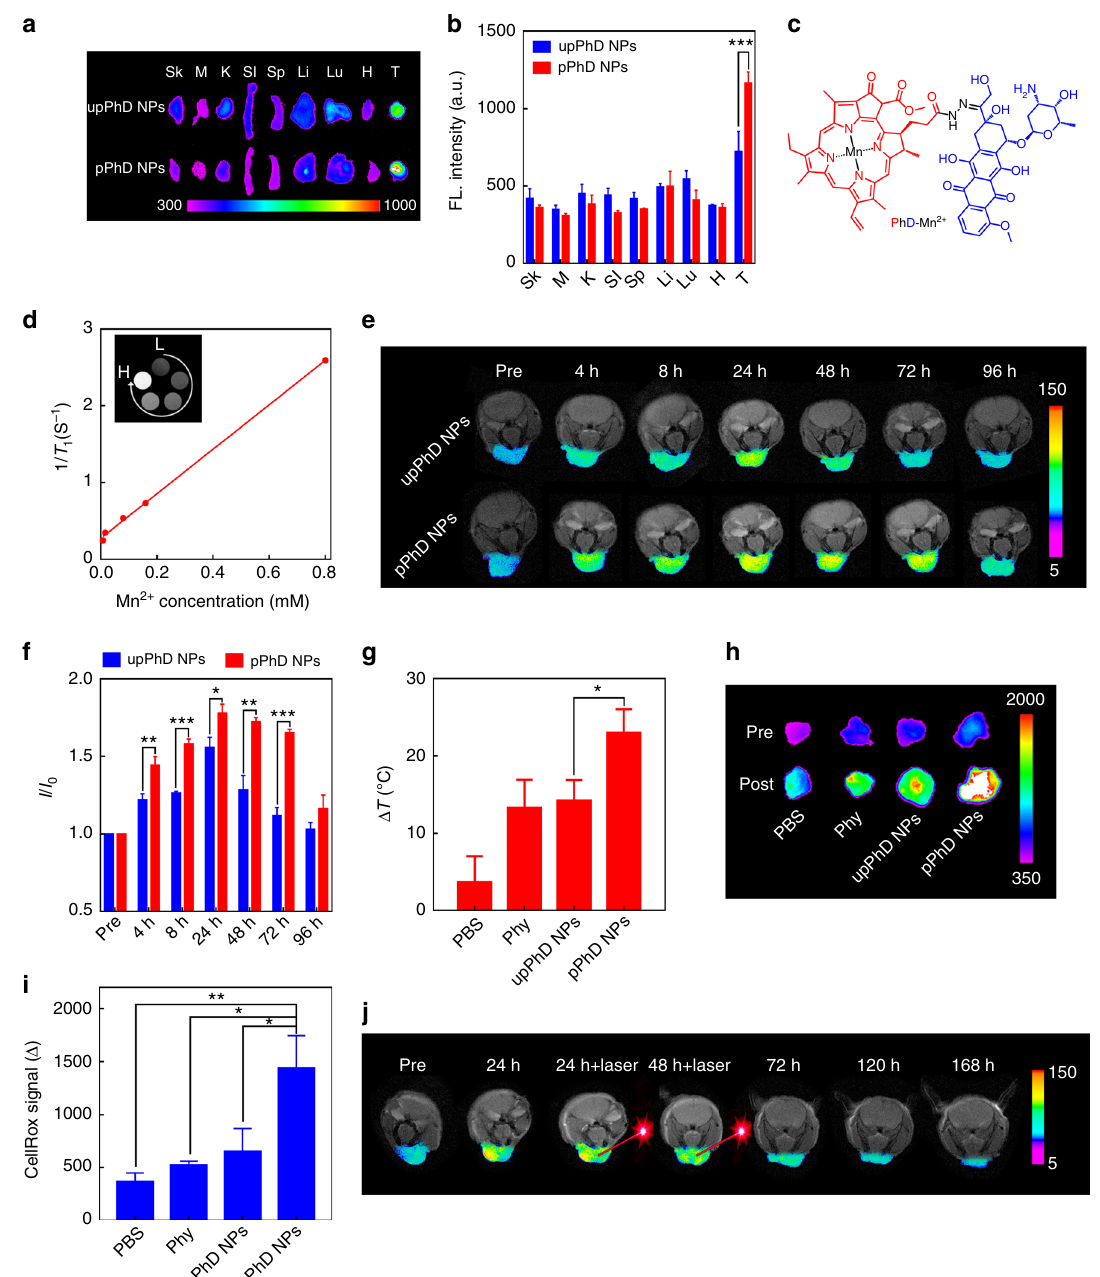
Fig. 4 In vivo evaluation of pPhD NPs in orthotopic oral cancer models. a NIRFI images and b quantitative fl uorescence with statistical analysis of the ex vivo distributions ( n = 3) of the nanoparticles. c Chemical structures illustrated the chelation of the manganese(II) ions (Mn 2 + ) to PhD molecules. d Concentration-dependent relaxation of Mn 2 + chelated pPhD NPs. The Mn 2 + chelated in pPhD NPs were 0.008, 0.016, 0.08, 0.16 and 0.8 mM, respectively. L denotes the low concentrations started at 0.008 mM, H denotes the high concentrations ended at 0.8 mM. e T1-weighted MRI images of time-dependent tumour accumulations ( n = 3) of the nanoparticles acquired on a 7 T MRI scanner and f the quantitative MR signal intensity changes ( I / I 0 ) on orthotopic oral cancer model. I is MR signal at a speci fi c timepoint, I 0 is the MR signal of the mice at Pre timepoint. Pre denotes the mice before Mn 2 + chelated pPhD NPs treatment. g Photothermal effects of the nanoparticles on orthotopic oral cancer model ( n = 6). The laser (680 nm) dose was 0.4 W cm – 2 for 3 min. h Fluorescence imaging of ROS productions within tumour tissues and i quantitative comparisons with statistical analysis of different treatments on orthotopic oral cancer model ( n = 3). The laser (680 nm) dose was 0.4 W cm – 2 for 3 min. The ROS productions were indicated by NIRF ROS probe, CellROX. Pre denotes the NIRFI before CellROX treatment; Post means the NIRFI after CellROX indication. j Phototherapeutic effect monitored by MRI. The laser (680 nm) dose was 0.8 W cm – 2 for 3 min. Pre denotes the MRI of the mice before treatment with Mn 2 + chelated pPhD NPs. For all animal experiments above, the injection doses of upPhD and pPhD NPs were 10 mg kg − 1 (calculated based on the concentration of PhD monomer). Phy was 5.3 mg kg − 1 . * p < 0.05; ** p < 0.01; *** p < 0.001. The units of the gradient bars are all given as arbitrary unit (a.u.) to present the fl uorescence or MRI signal intensities are relatively higher or lower. All error bars are presented as standard